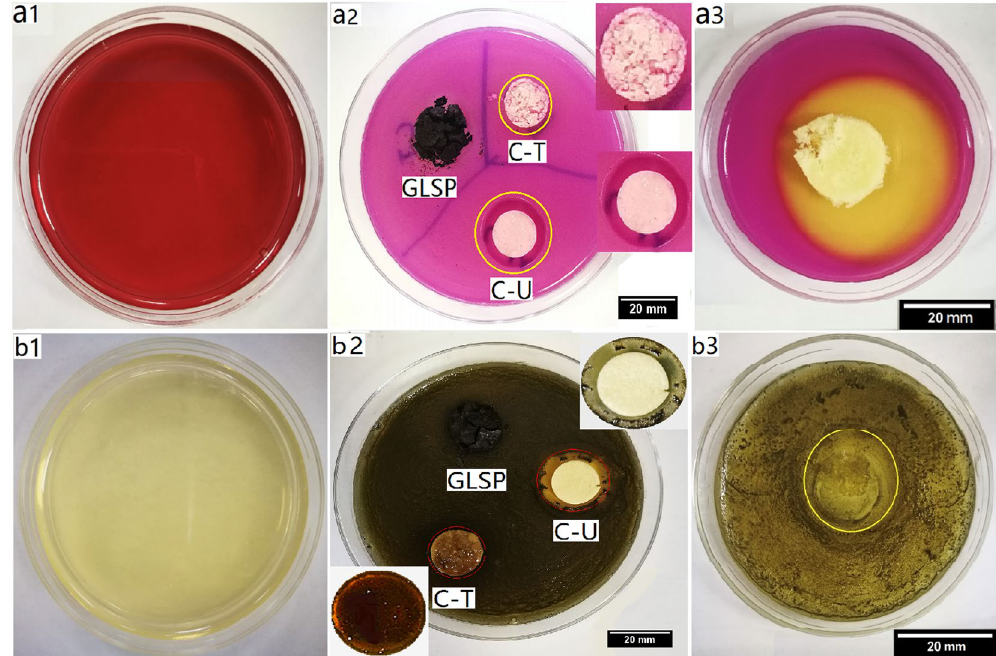
Figure 7. Effect of antibacterial activity assay. ( a1 ) Violet red bile agar plate. ( a2 ) Antibacterial effect of GLSP, C-T and C-U on E. coli post 24 h inoculation at 37 °C ( b1 ) baird-parker agar plate. ( b2 ) Antibacterial effect of GLSP, C-T and C-U on S. aureus post 24 h inoculation at 37 °C ( a3 and b3 ) antibacterial effect of C-C on E. coli and S. aureus ,